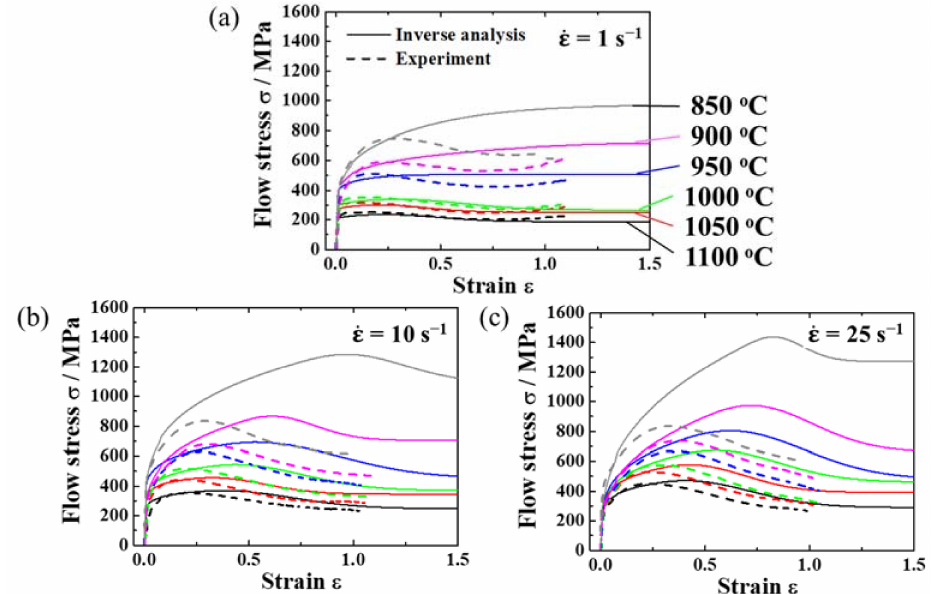
Figure 3. Flow curves obtained from experiment (dotted line) and inverse analysis (line) at deforma- tion temperatures from 850 to 1100 ◦ C and strain rates of ( a ) 1, ( b ) 10, and ( c ) 25 s − 1